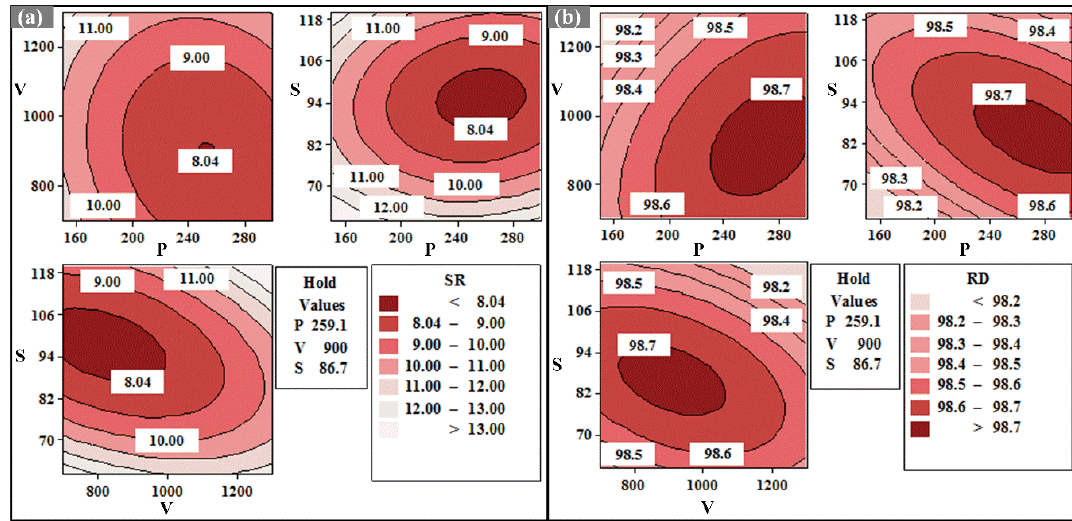
Figure 6. Contour plots of ( a ) SR and ( b ) RD at hold values of P (259.1 W), V (900 mm/s), and S (86.7 μm), respectively.